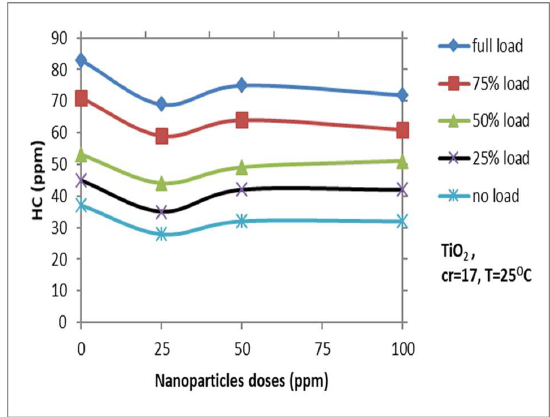
Fig. 9. Unburnt Hydrocarbon Emissions (UHC) with Titanium nanoparticles doses.